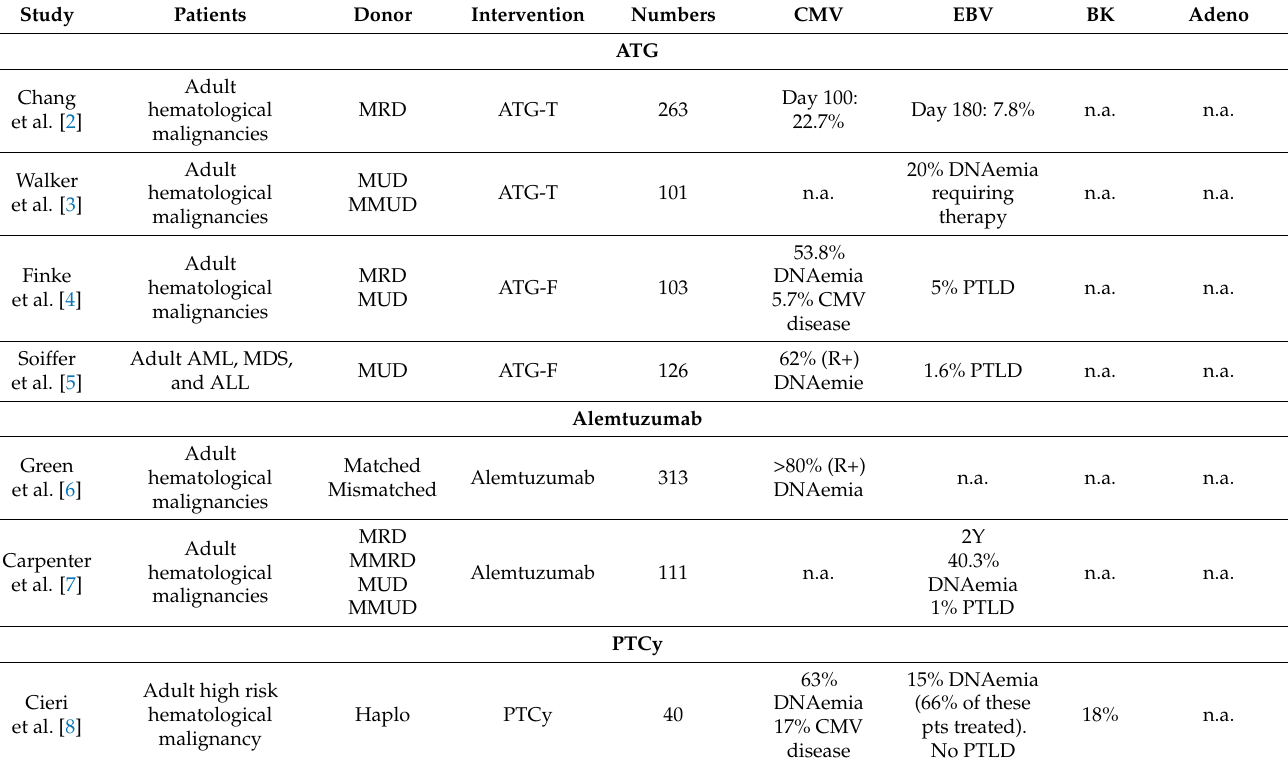
Table 1. Studies reporting on type of transplantation and viral reactivations or infections. Adapted and modified from de Witte et al.